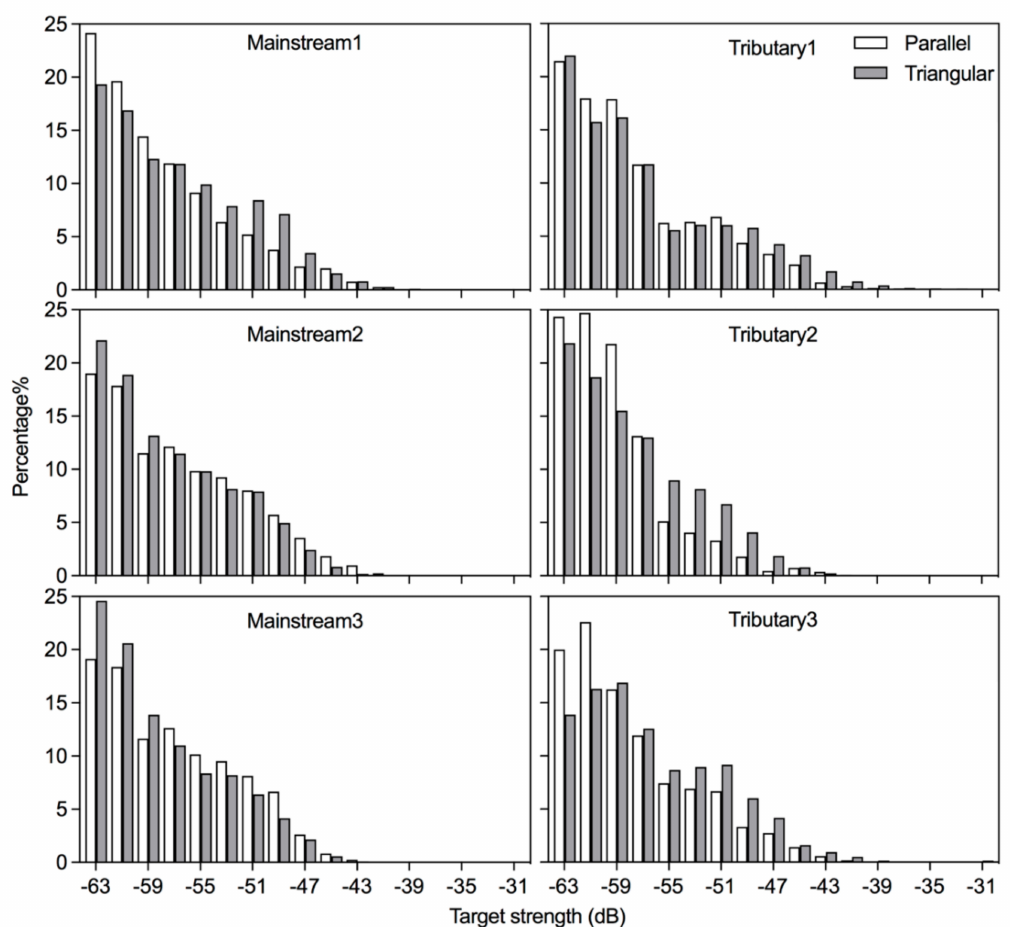
Figure 3. Frequency distribution of fish target strength (TS) estimated acoustically under the two types of survey designs in the mainstream and the tributary. The horizontal axis represents the intervals of TS (2 dB wide), and the vertical axis represents the percentage of individual fish corresponding to each interval of